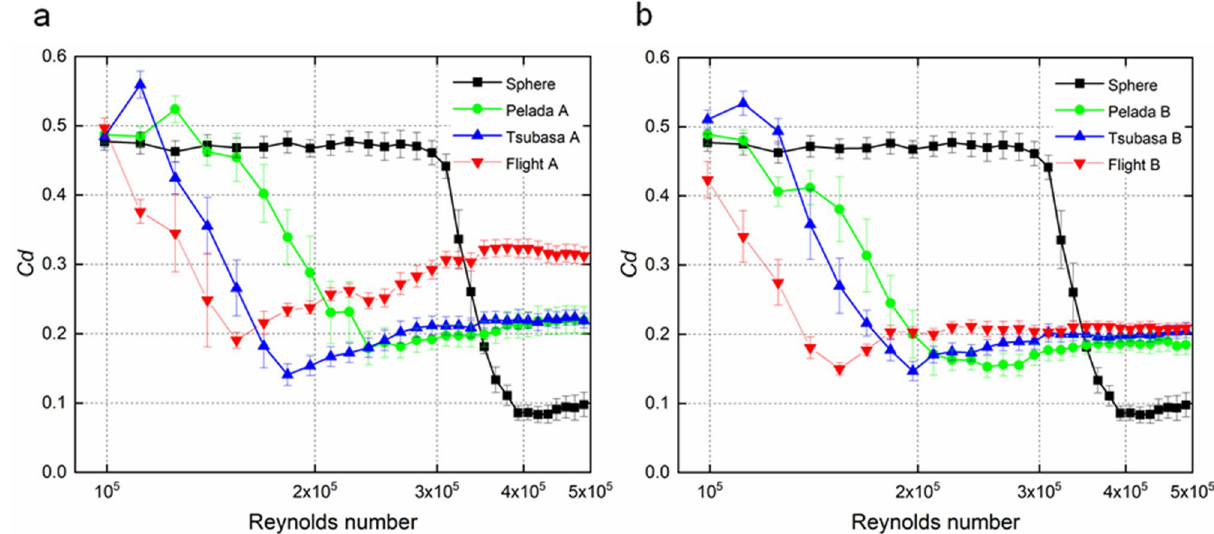
Figure 3. Drag coefficient versus Reynolds number for each type of ball and panel orientation: ( a ) symmetric and ( b ) asymmetric orientations.